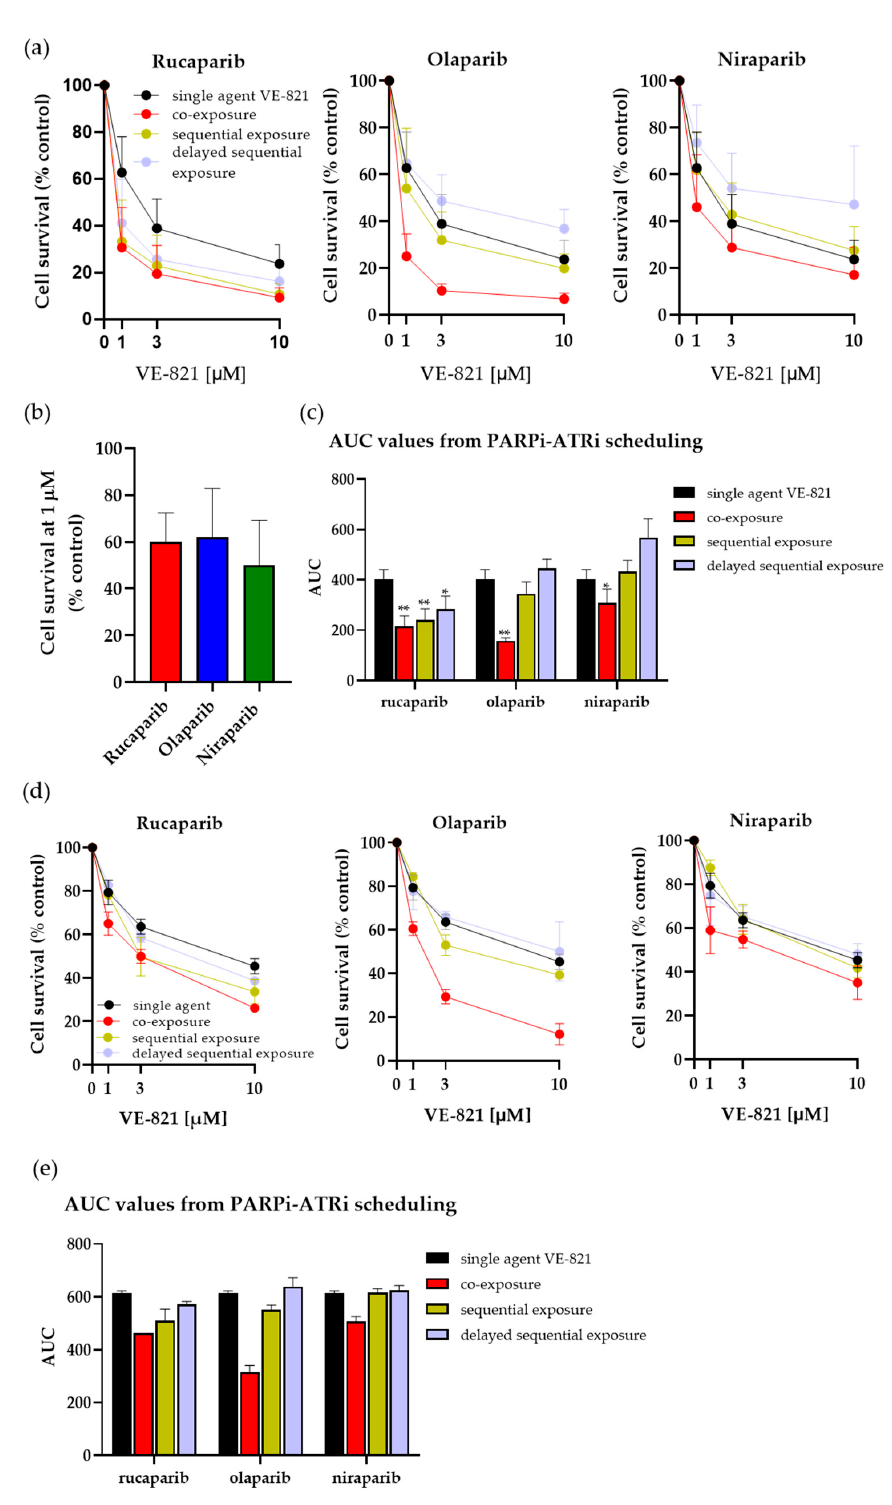
Figure 3. Enhancement of VE-821 cytotoxicity by rucaparib, olaparib and niraparib on different schedules. Cells were exposed to VE-821 at indicated concentrations, either as single agents or with 1 µM rucaparib, olaparib or niraparib, and either with co-exposure, sequential exposure or 24 h delayed sequential exposure; then, they were incubated for 10–14 days for colony formation in IGROV-1 ( a ) and ES-2 ( d ) cells. ( b ) IGROV-1 cells were exposed to 1 µM rucaparib, olaparib and